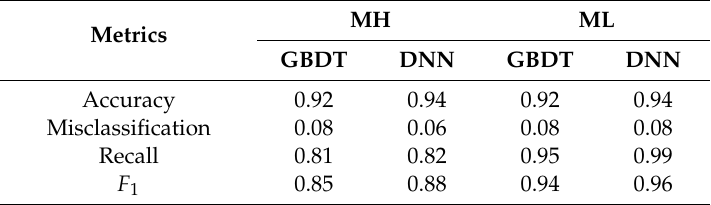
Table 3. The validation results of prediction models in the first